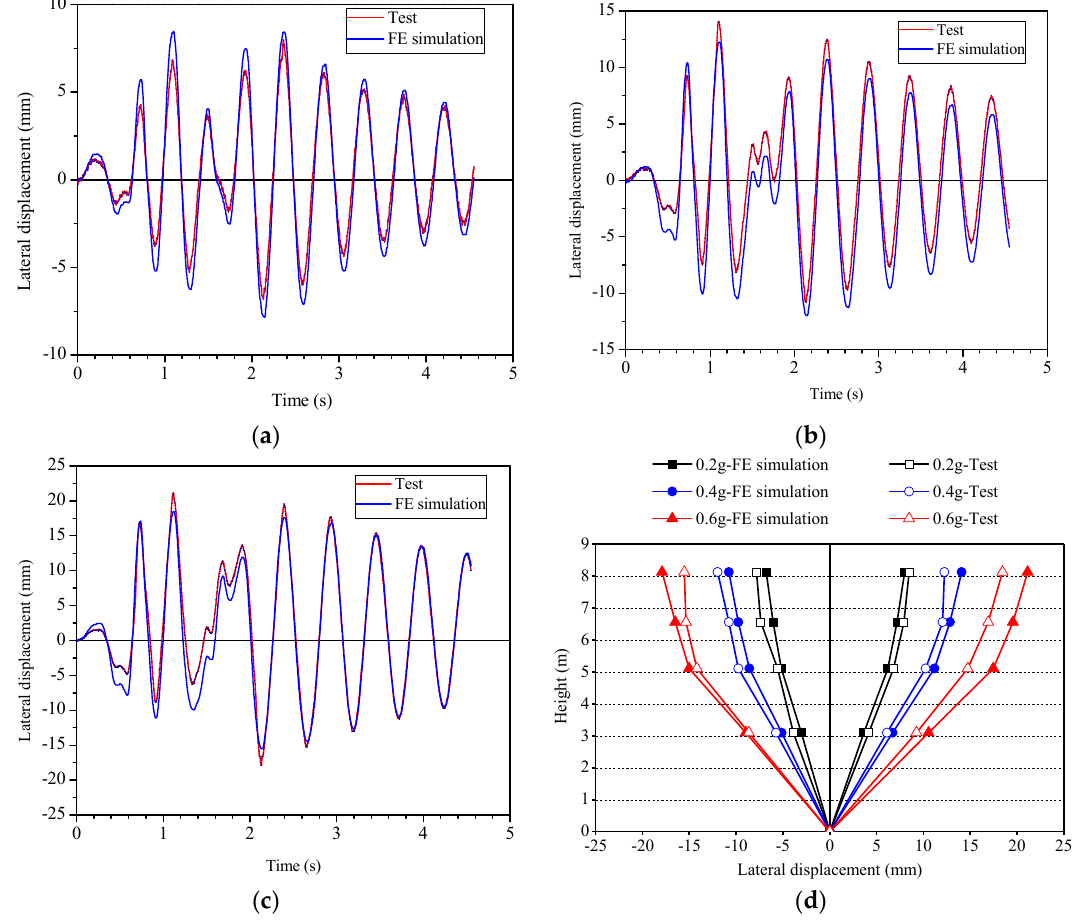
Figure 5. Comparison of numerical and test lateral displacements: ( a ) Top of A-shaped frame under 0.20 g; ( b ) top of A-shaped frame under 0.40 g; ( c ) top of A-shaped frame under 0.60 g; ( d ) maximum lateral displacements.